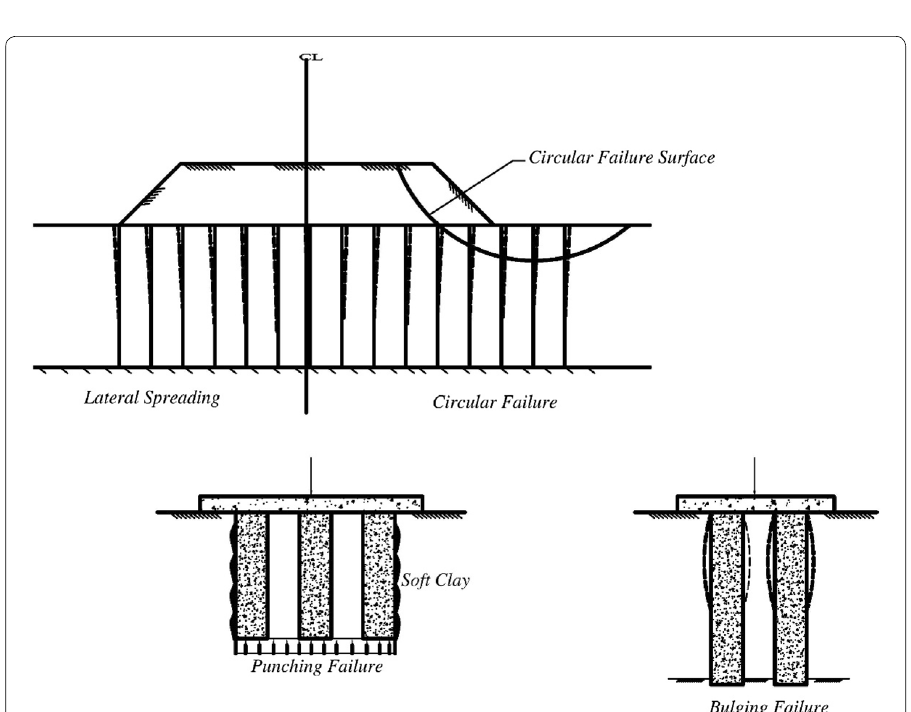
Fig. 13 Failure modes of sand columns under wide flexible